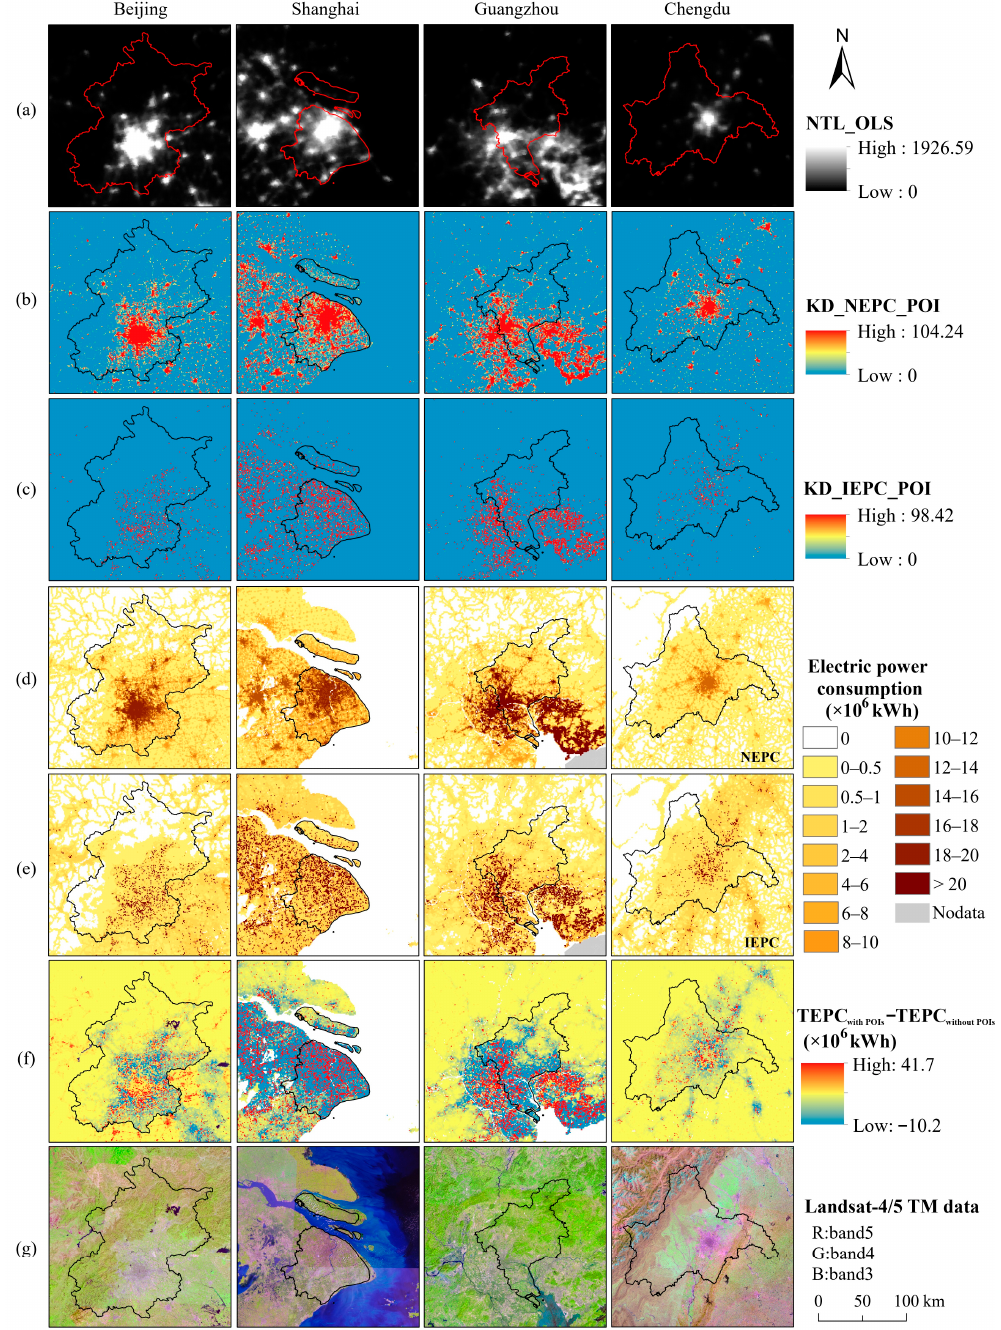
Figure 8. Comparison among ( a ) the radiance-calibrated DMSP-OLS NTL product (NTL_OLS); ( b ) the kernel density of the NEPC-related POIs; ( c ) the kernel density of the IEPC-related POIs; ( d ) the estimated NEPC distribution; ( e ) the estimated IEPC distribution; ( f ) the differences between the TEPC predictions with and without POIs data; and ( g ) the Landsat-4/5 TM images for four cities in mainland